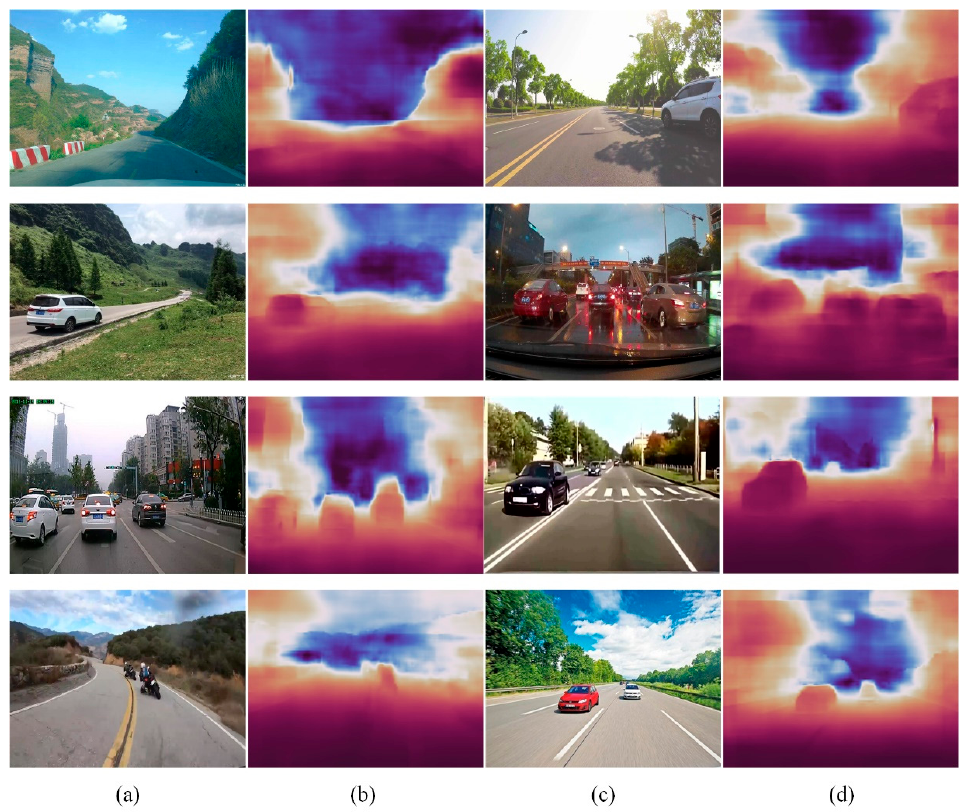
Figure 10. Depth estimation results of the proposed method on the collected road samples. ( a , c ) Images from the internet; ( b , d ) proposed